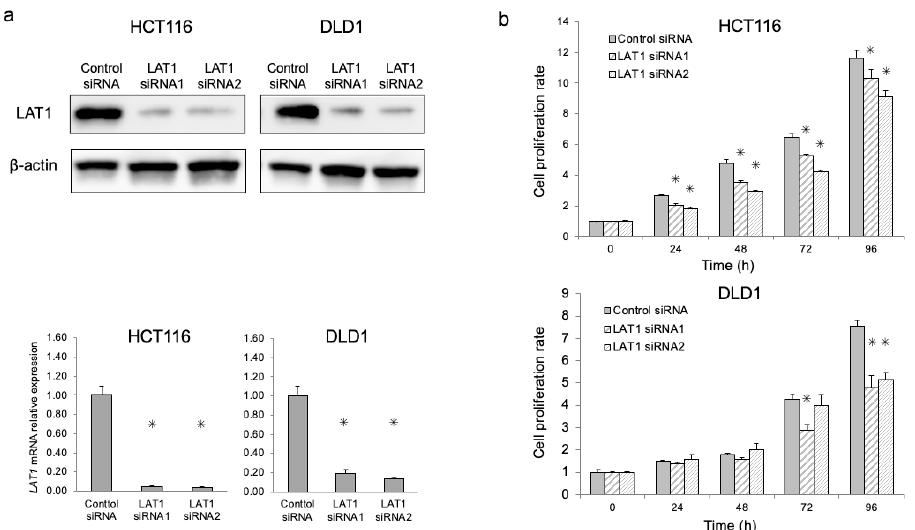
Figure 3. Functional analysis of LAT1 in human CRC cell lines. ( a ) LAT1 suppression was evaluated in HCT116 and DLD1 cells treated with LAT1 siRNAs by Western blotting and qRT-PCR. β-actin was used to normalize the loading control for the Western blot. ( b ) The proliferation of CRC cells after LAT1 siRNA treatment was evaluated using a Cell Counting Kit-8 kit. * p < 0.05.